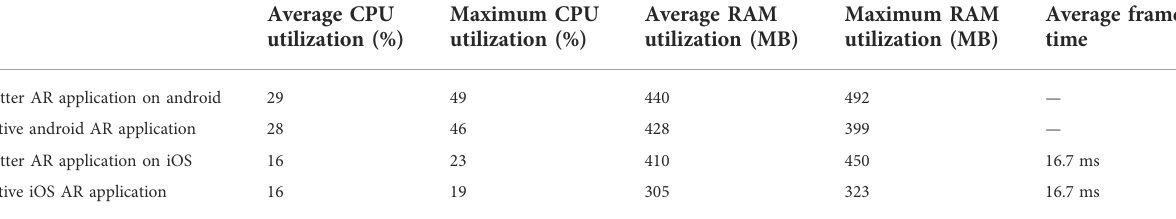
TABLE 5 Performance measurements during the run of an AR session benchmark of fl utter and native apps on android and iOS devices.